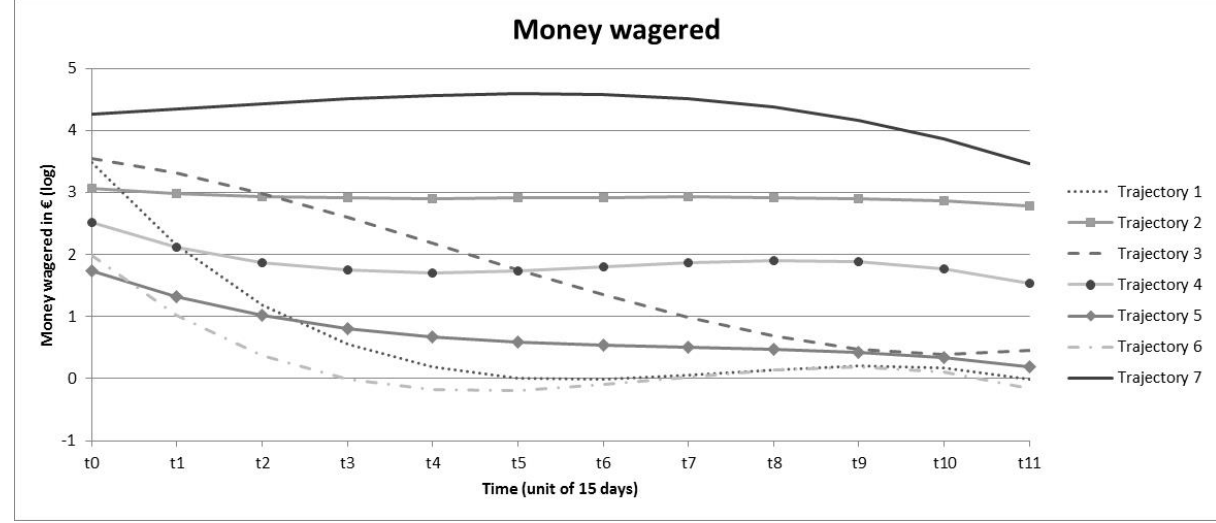
Figure 1. Trajectories obtained from growth mixture models for amount wagered. The ordinate axis represents the log-transformation of amount wagered. A value of 1 corresponds to €2, 2 to €6, 3 to €19, 4 to €54, and 5 to €147.